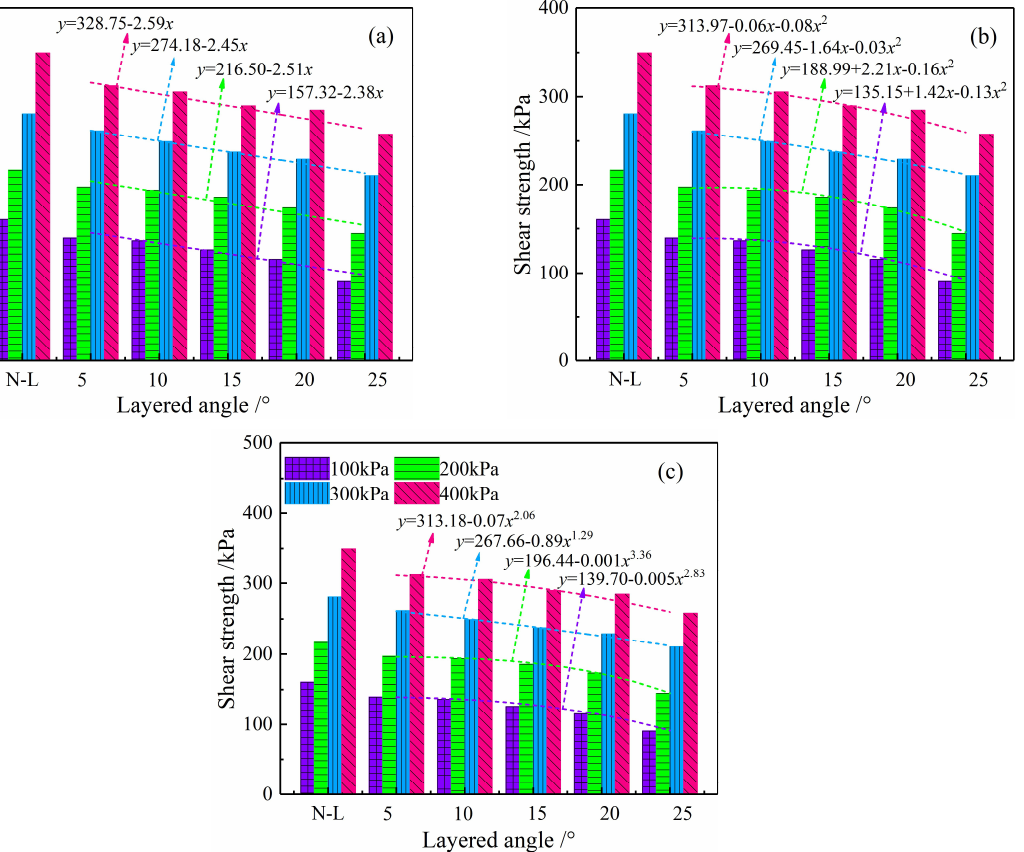
Figure 10. Relationship between layered angle and shear strength of layered CPB: ( a ) linear fitting; ( b ) polynomial fitting; ( c ) exponential fitting.